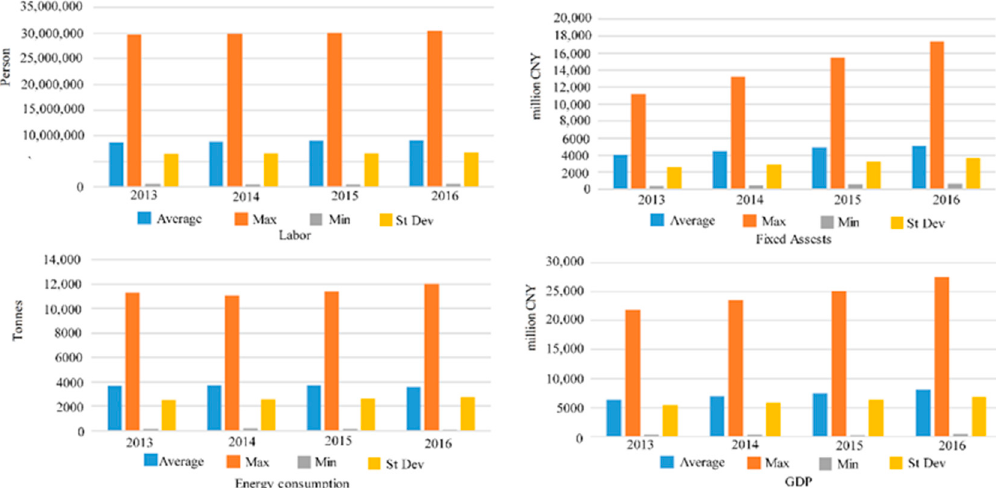
Figure 3. Labor, fixed assets, energy consumptions from 2013–2016.